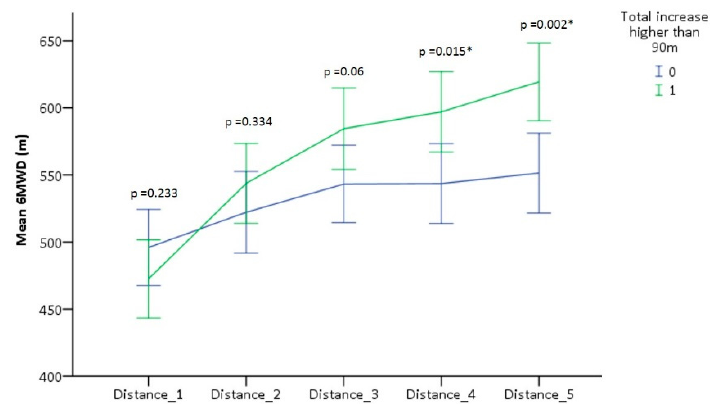
Figure 2. Means and standard deviations of six-minute walking distance (6MWD) walked during rehabilitation for subgroups based on the increase in distance throughout rehabilitation. * p < 0.05.